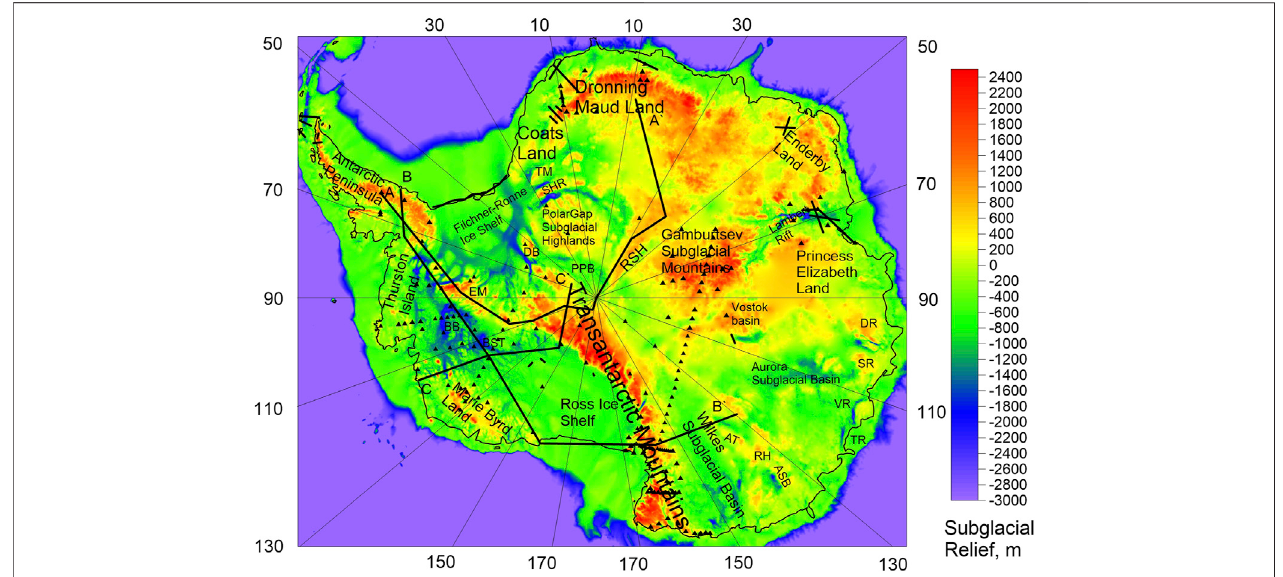
FIGURE1| SubglacialreliefinAntarcticaaccordingtoBEDMACHINE(Morlighemetal.,2020).Notationused:blacktrianglesrepresentseismicstations;blacklines representseismicpro fi les.Usedabbreviation:PPB,Pensacola-PoleBasin;EM,EllsworthMountains;BB,ByrdBasin;BST,BentleySubglacialTrench;SHR,Shackleton Range; TM, Theron Mountains; SR, Scott rift; DR, Denman rift; VR, Vanderford rift; TR, Totten rift; AT, Adventure Trench; ASB, Astrolabe Subglacial Basin; RH, Resolution Highlands; DB, Dufek Block; RSH, Recovery Subglacial Highlands.